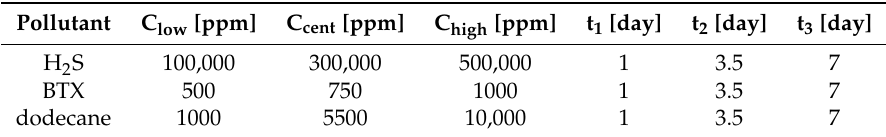
Table 1. The experimental boundaries in this